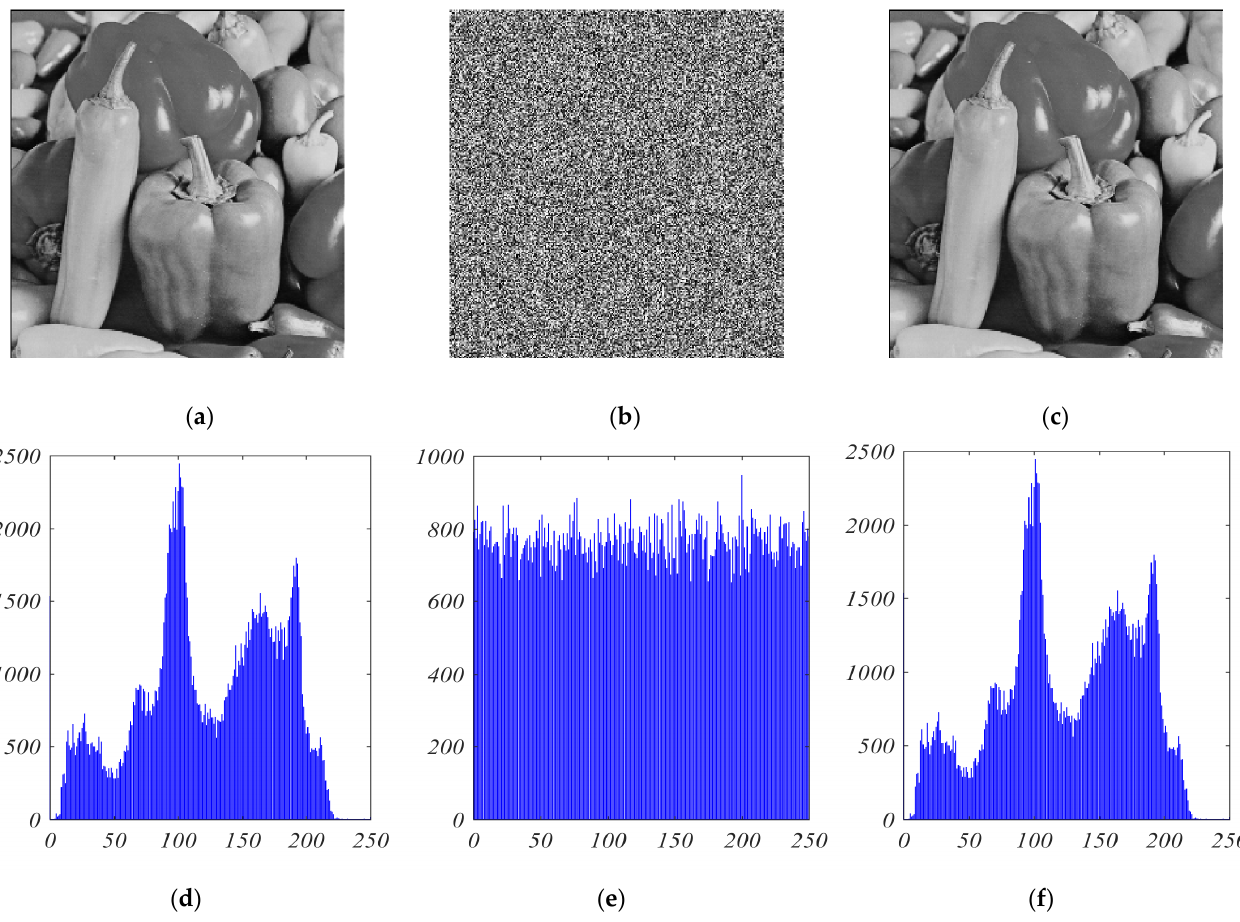
Figure 21. Encryption and decryption of “Peppers.pmb” 256 × 256 grayscale image: ( a ) the original image; ( b ) encrypted image; ( c ) the decrypted image; ( d ) histogram corresponding to ( a ); ( e ) histogram corresponding to ( b ); ( f ) histogram corresponding to ( c ).